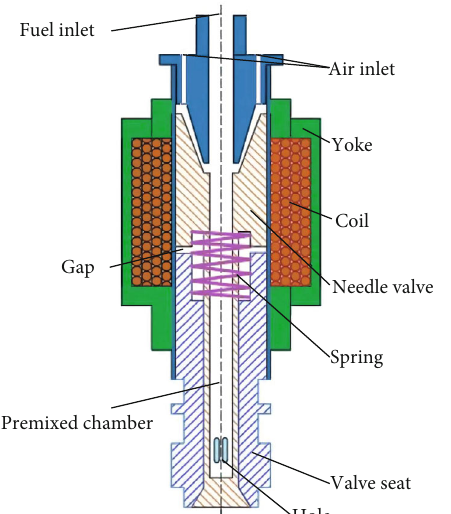
Figure 5: Internal structure of the air-assisted injector.